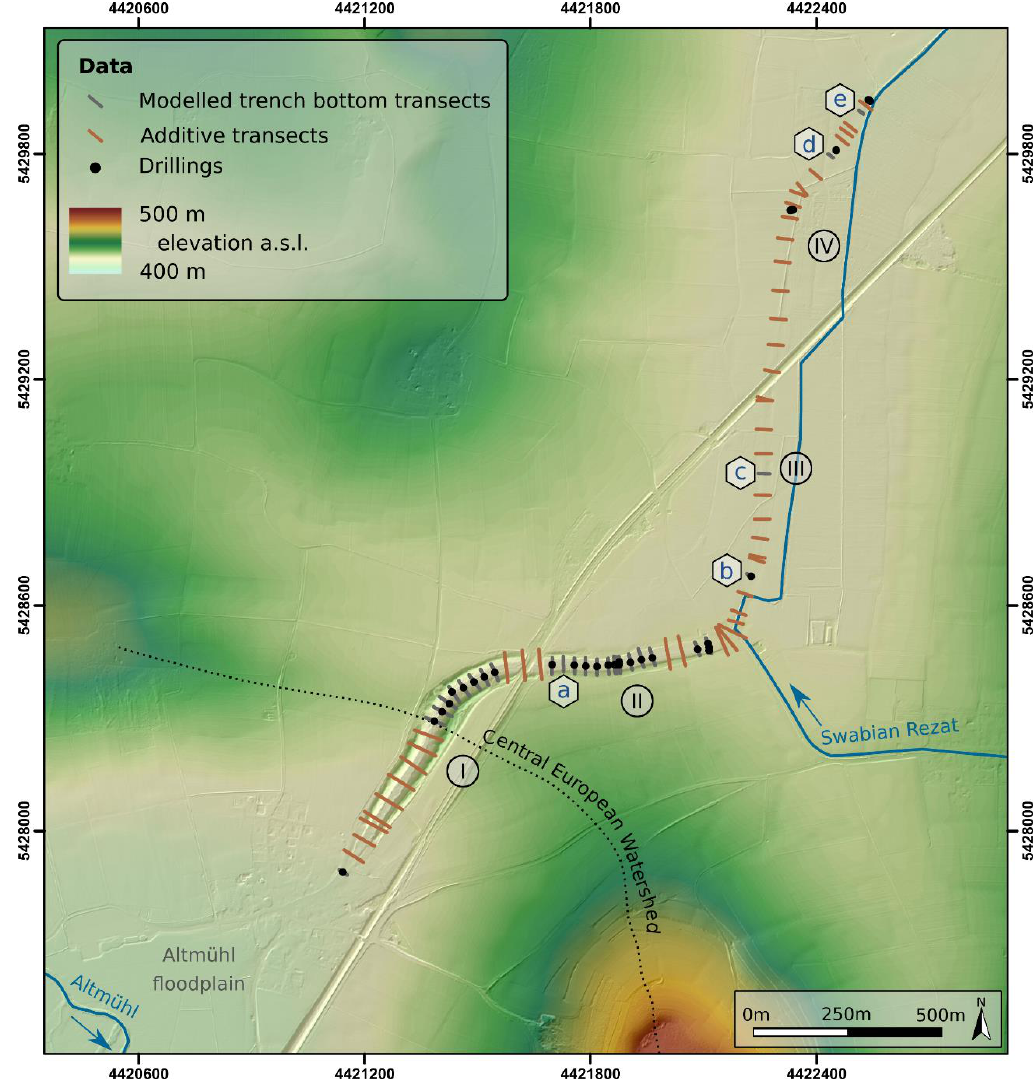
Figure 2: Local setting and course of the Fossa Carolina and its subdivision in I) Central Section, II) West-East Section, III) Northern Section, IV) North-Eastern Section. All input data for the subsequent modelling are shown, including drillings, modelled trench bottom transects and additive transects.